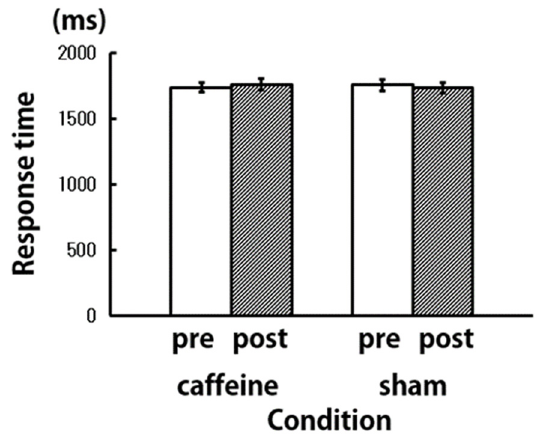
Figure 5. Percentage of correct answer in the letter 3-back working memory task ( N = 9).